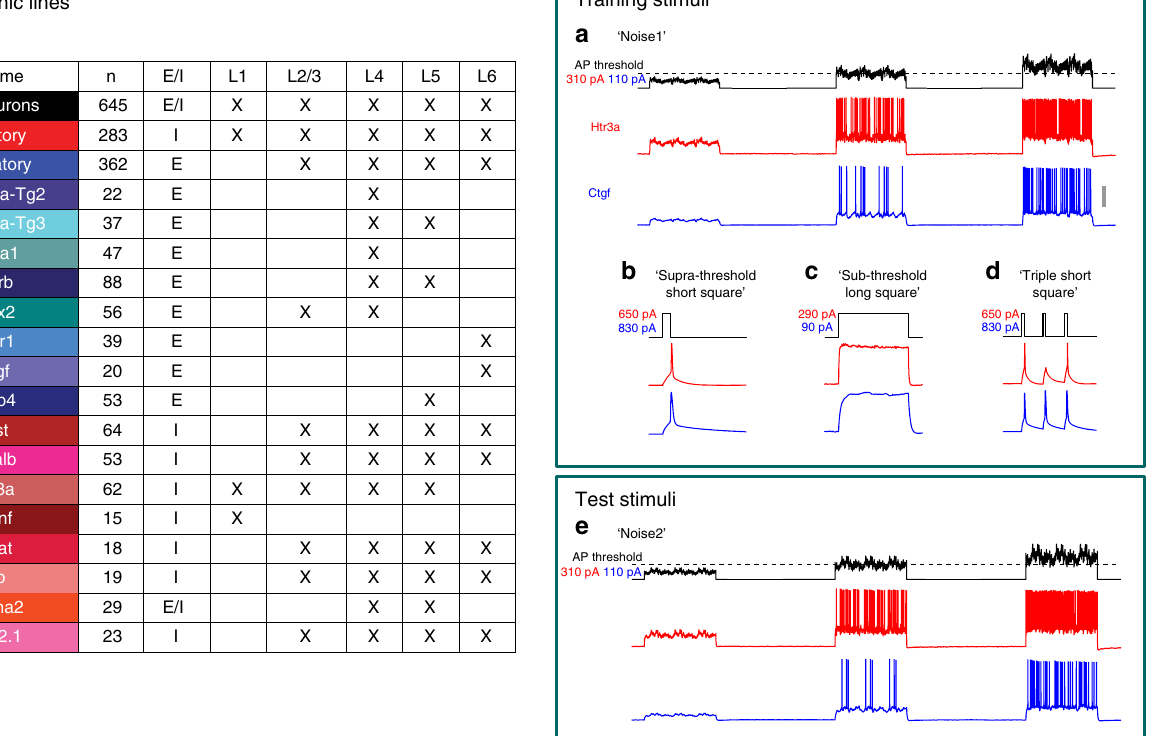
Fig. 2 Overall, 645 different neurons from 16 transgenic lines containing all the required stimuli on the Allen Cell Types Database are considered in this study. (Left) Illustrated colors correspond to the different transgenic lines in all fi gures. “ n ” describes the number of neurons for which the lowest level model ( GLIF 1 ) could be generated. Transgenic lines can identify either or both inhibitory (I) or excitatory (E) cells, which reside in layer 1 (L1) through layer 6 (L6). Note that most Chrna2-Cre-positive neurons are inhibitory and thus are labeled here as inhibitory. (Right) A minimal set of stimuli were required for training and testing different GLIF models. GLIF models were trained using a at least two repeats of pink noise stimuli (3 s each, 1/ f distribution of power, 1 – 100 Hz) with amplitudes centered at 75, 100, and 125 percent of action potential threshold, b a short (3 ms) just supra-threshold pulse to fi t the instantaneous threshold, Θ ∞ , c a long square (1 s) pulse just below threshold to estimate the intrinsic noise present in the voltage traces (used in the post hoc optimization step), and d a series of three peri-threshold short pulse sets for any model with reset rules ( GLIF 2 , GLIF 4 , and GLIF 5 ). GLIF models